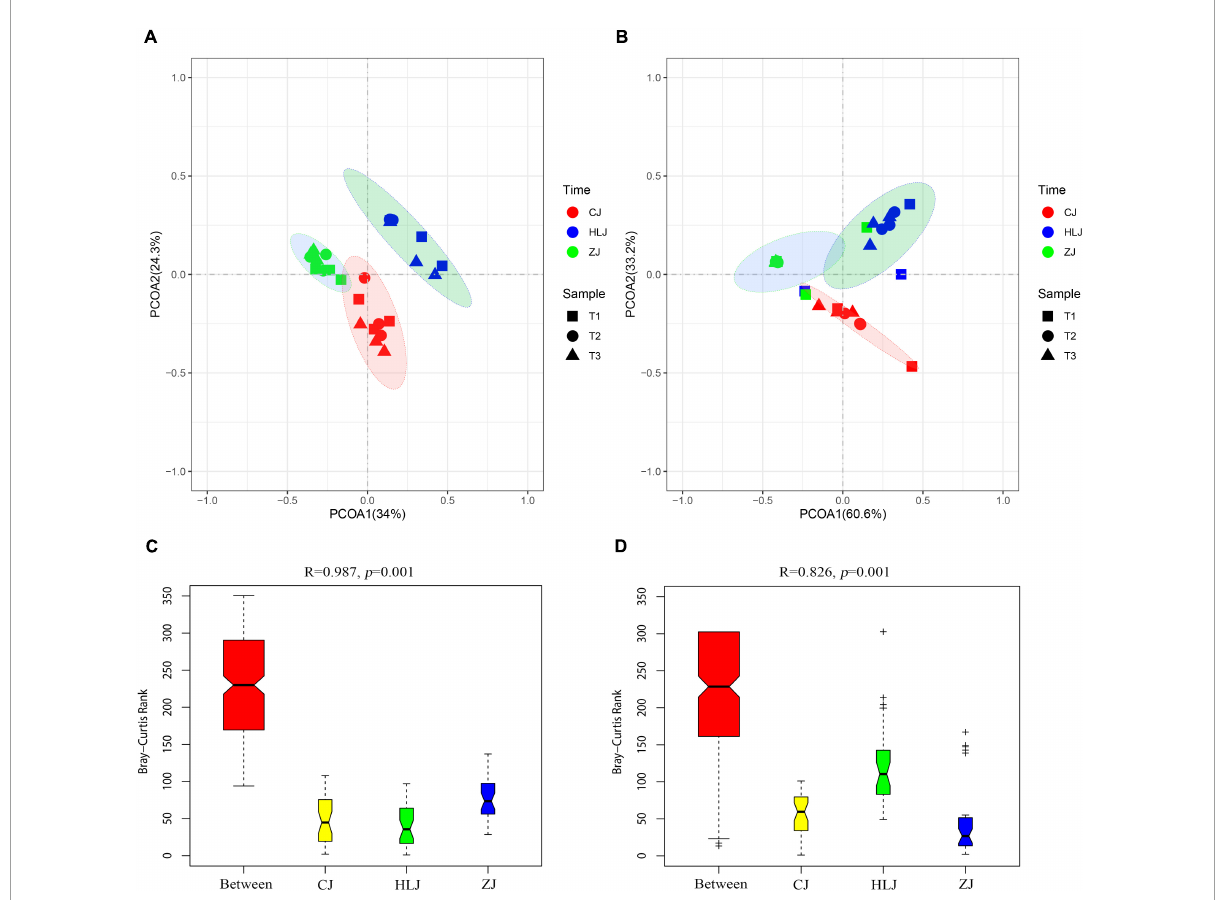
FIGURE2 Principal coordinates analysis (PCoA) plots of the ammonia-oxidizing archaea (AOA) (A) and ammonia-oxidizing bacteria (AOB) (B) community using the weighted UniFrac distance metric, and analysis of similarity (ANOSIM) analysis based on Bray-Curtis distances of AOA (C) and AOB (D) community dissimilarity/similarity from sediment samples in different areas. Ellipses were drawn for AOA and AOB with confidence intervals of 95 and 75%, respectively. T1–3 represent different sampling times, and CJ, HLJ, and ZJ represent sediment samples collected in different